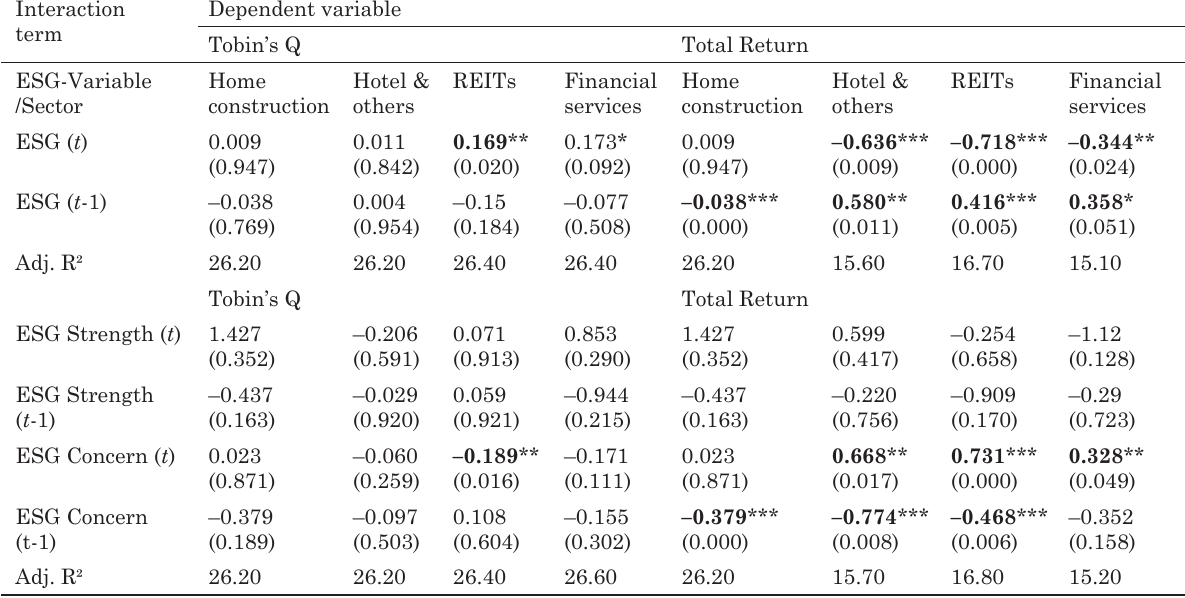
Table 7. Panel fixed effects regression with sub-sector interaction terms